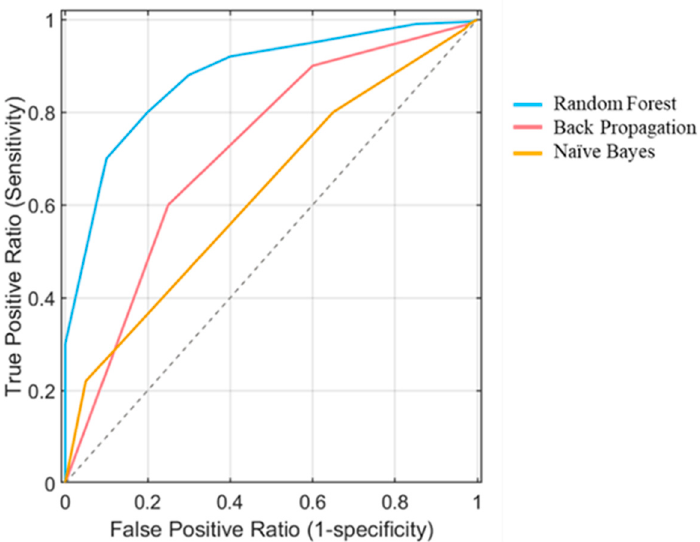
Figure 11. Comparison of ROC of three methods. The area under the curve is called AUC (area under curve), which is used to indicate the prediction accuracy. The accuracy of random forest is greater than back propagation is greater than Naïve Bayes.